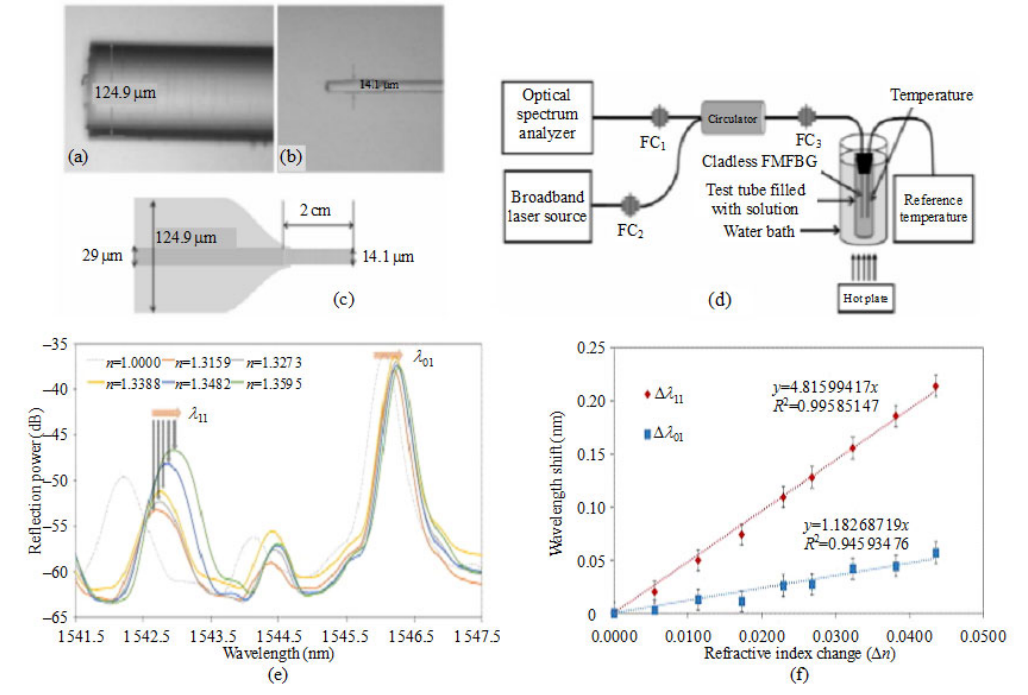
Fig. 2 Microscope images, experimental setup, and RI response of the FBG sensor based on the FMF